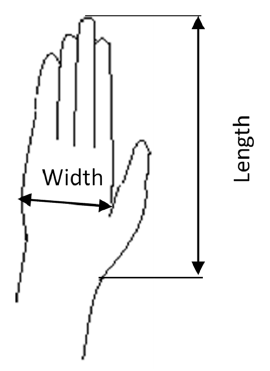
Figure 1. Hand area.